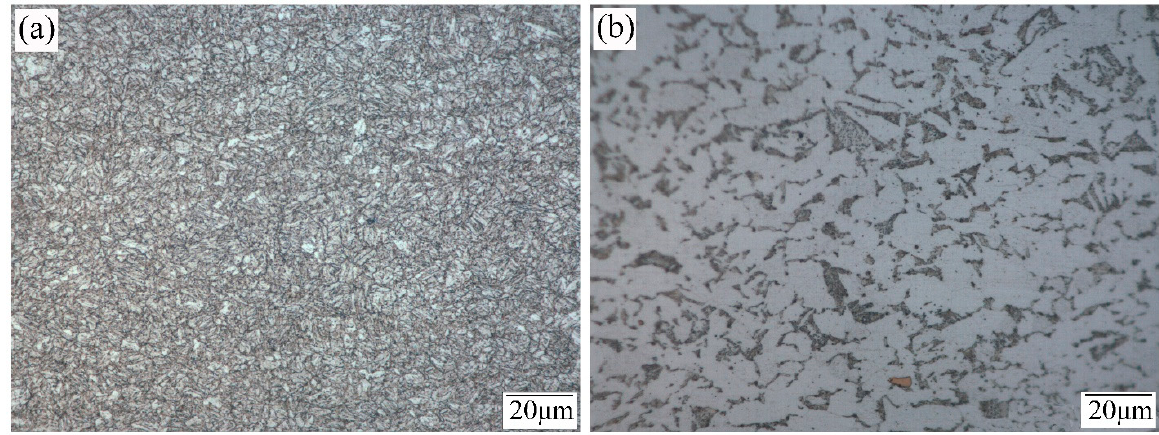
Figure 2. Microstructure of 6252 armor steel and Q550D at 1000×. ( a ) 6252 ( b ) Q550.